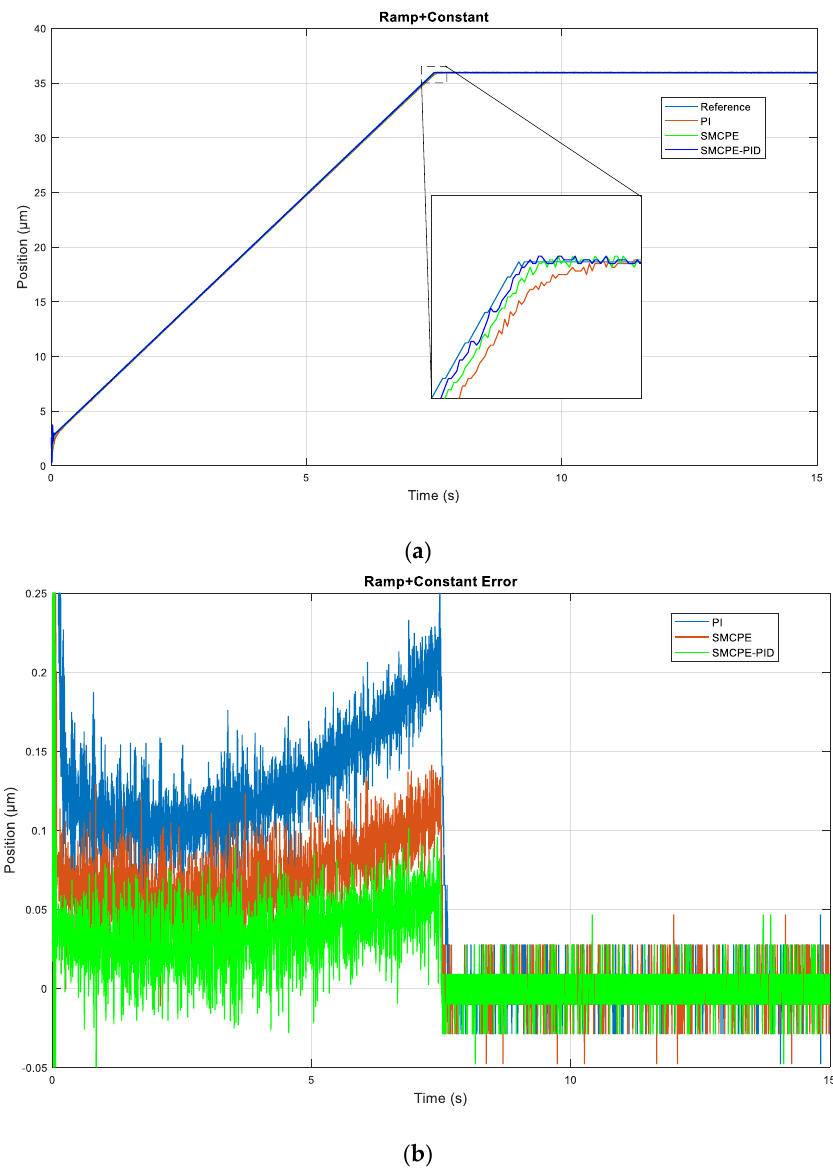
Figure 8. ( a ) Position and ( b ) Error.